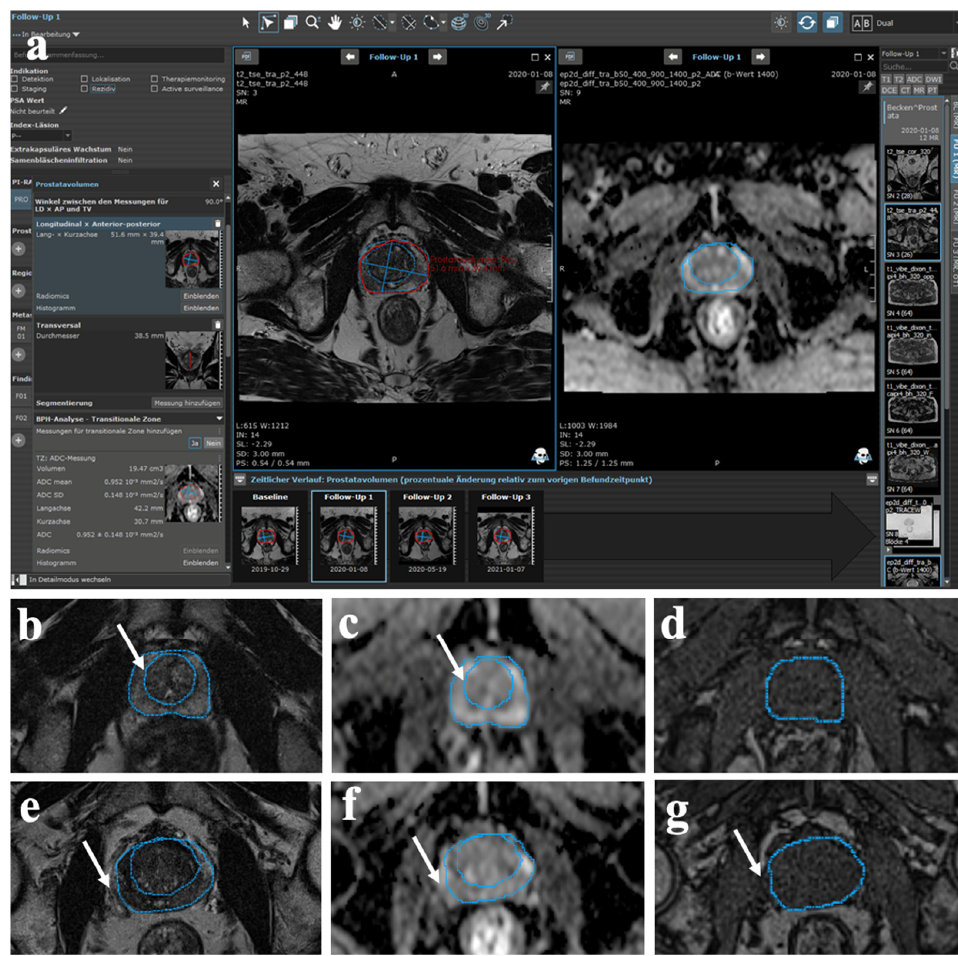
Figure 1. Methodology. MRI analysis using the dedicated semi-automatic software tool mint Lesion™. ( a ) Software surface for the systematic and standardized assessment of volumetric and morphological characteristics after PAE. ( b , e ) Axial T2w MR images after segmentation of the CG (arrow in ( b )) and the TG (arrow in ( e )) performed for each slice, respectively. ( c , f ) Subsequent automatic transfer of both measurements to the corresponding slice levels of the axial DWI sequence (arrows). ( d , g ) Subsequent automatic transfer of the measured TG to the corresponding slice levels of the axial T1w MRI sequence (arrow).